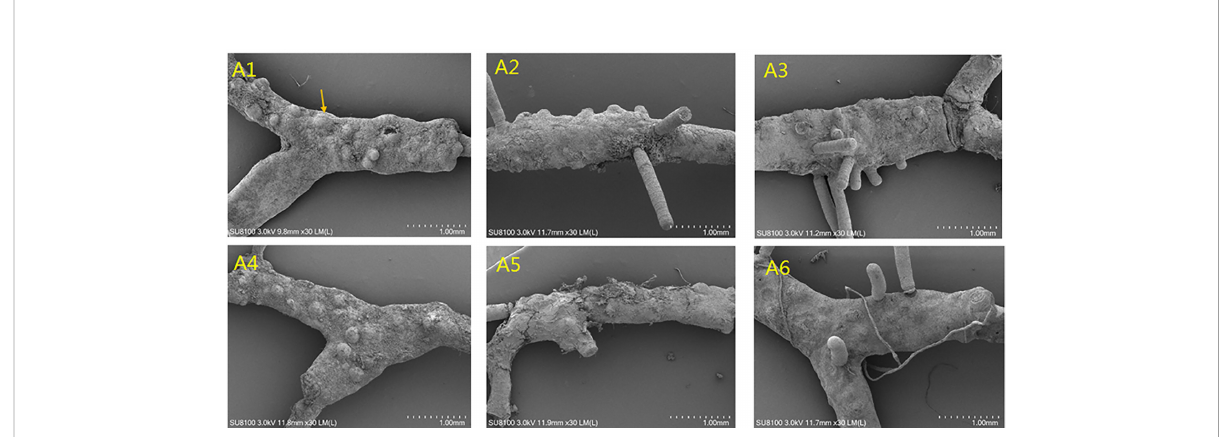
FIGURE 2 The effects of temperature and light intensity on algal surface by SEM (A1: 60 m mol photons m − 2 s − 1 , 26°C; A2: 80 m mol photons m − 2 s − 1 , 26°C; A3: 120 m mol photons m − 2 s − 1 , 26°C; A4: 60 m mol photons m − 2 s − 1 , 32°C; A5: 80 m mol photons m − 2 s − 1 , 32°C; and A6: 120 m mol photons m − 2 s − 1 ,